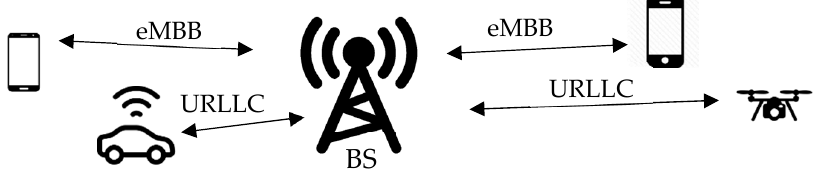
Figure 4. Coexistence of URLLC and eMBB. BS, base station.